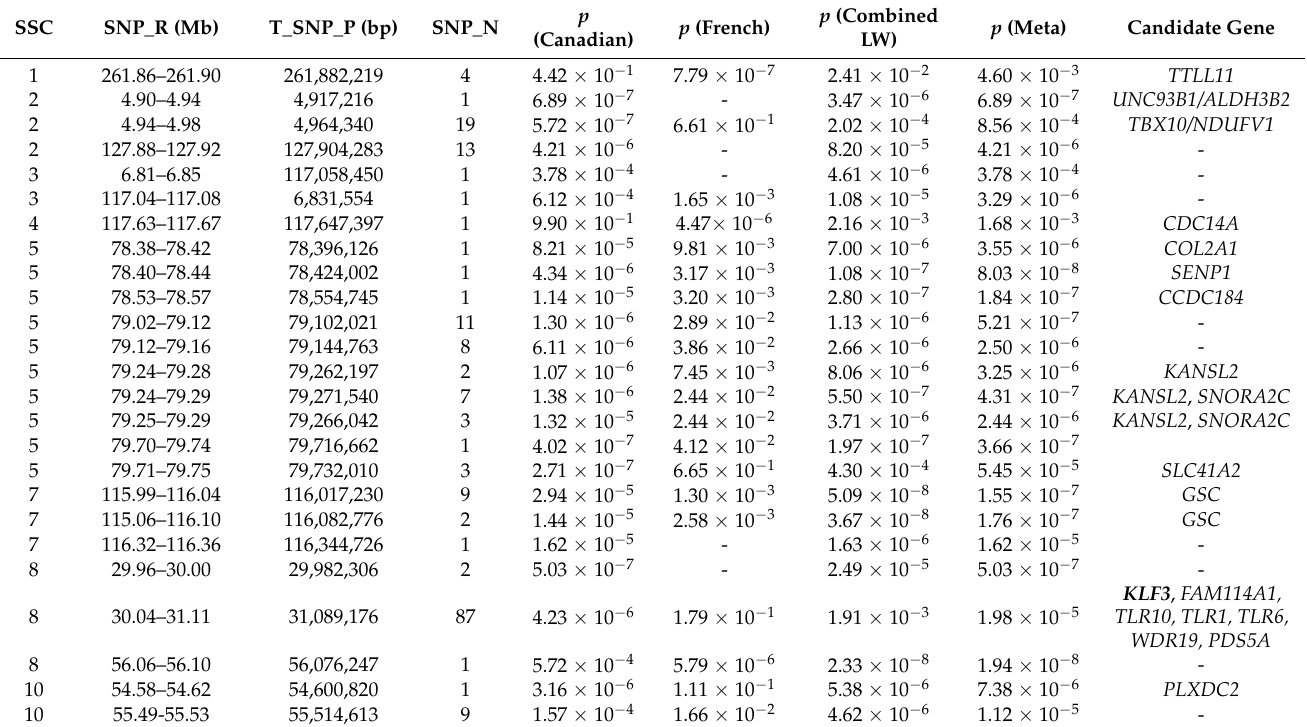
For the TNB trait, the Manhattan plots are shown in Figure 2e–h. The Q-Q plots are shown in Supplementary Figure S2e–h, with genome inflation factors between 0.969 and 0.993 (Supplementary Table S3). For the GWAS analysis within both Large White lines, no genome-wide significant SNPs were detected. There were 147 SNPs at the suggestive significant level in the Canadian line and 136 SNPs at the suggestive significant level were in the French line. In the GWAS analysis of the combined lines of Large White population, there were 3 SNPs at the significant level and 203 SNPs at the suggestive significant level. There were 175 SNPs at the suggestive significant level in the cross-population meta-anal- yses (Table 3). Table 3. The genome significant and suggestive SNPs with the total number born (TNB) trait using imputed WGS data in pigs.